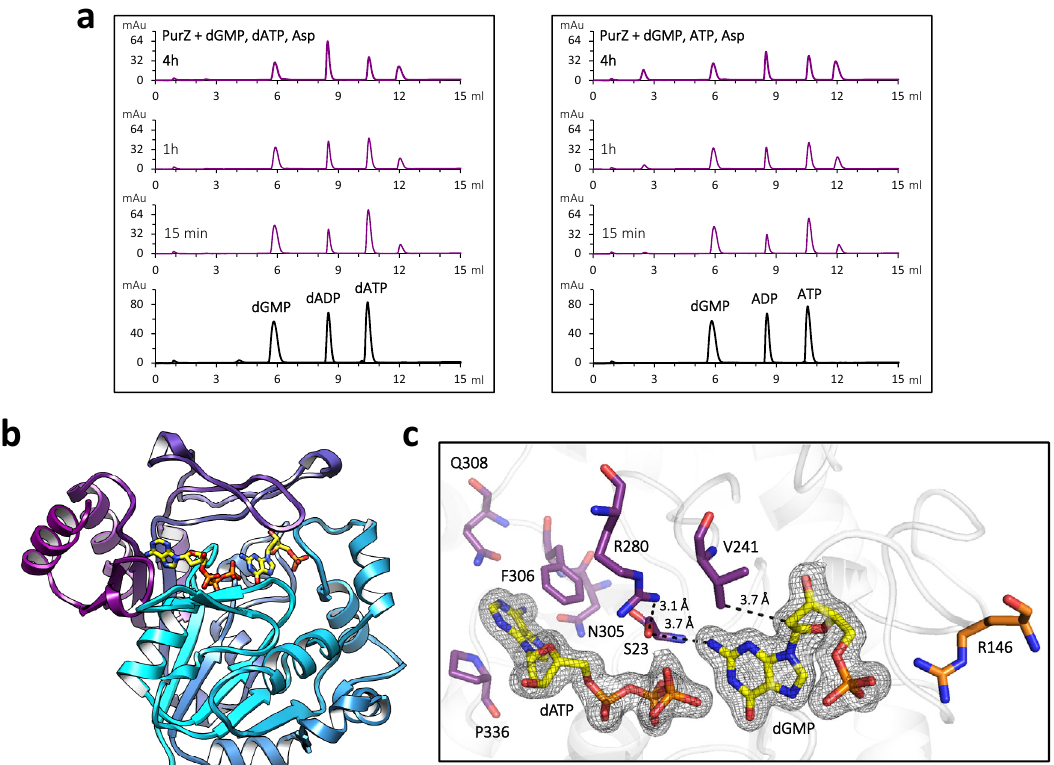
Fig. 2 dATPase activity of S-2L PurZ: functional assay and ligand-bound structure. a HPLC pro fi les representing the time-course of the reaction catalyzed by PurZ in presence of dGMP, Asp and dATP/ATP (purple). Pure compounds used as standards are shown below in black. The enzyme generates products corresponding to (d)ADP and dSMP. b Ribbon representation of a PurZ crystallographic protomer, with dGMP and dATP shown in stick (yellow). c Catalytic pocket of PurZ with the 2 F o − F c electron density contoured around the reactants at 1 σ (black mesh). Crucial residues surrounding the nucleotides are coloured by chain (purple and